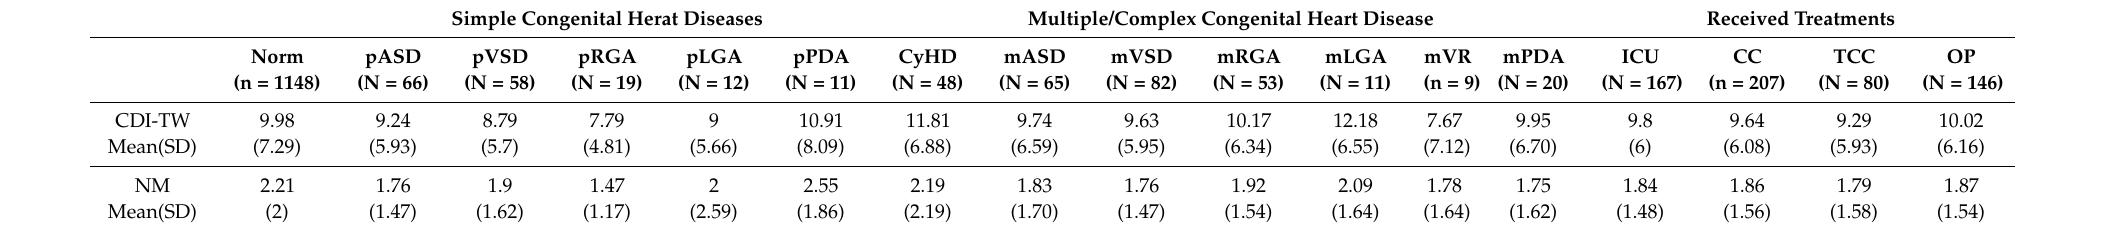
Table 2. Children Depression Inventory-TW scores in children and adolescents with congenital heart